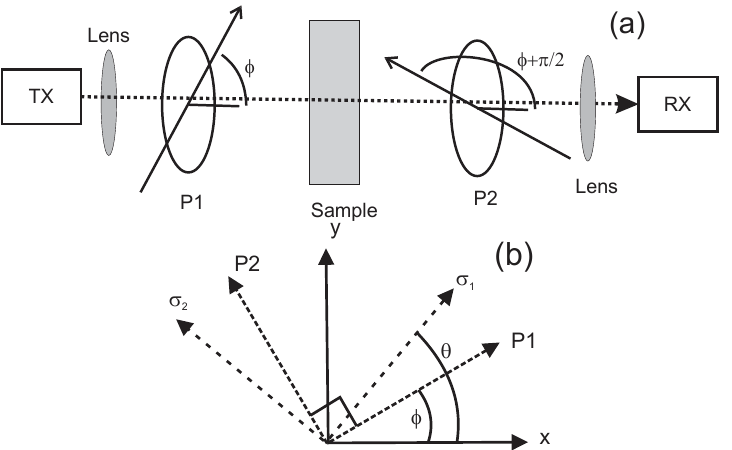
Figure 1. Experimental configuration for measurement of birefringence in a transmission mode. ( a ) relative positions of the transmitter/polarizer P1 module, birefringent sample, and receiver/polarizer P2 module. ( b ) Orientation of transmission axes of polarizers P1 and P2 relative to the laboratory x and y axes. The terahertz pulse is propagating into the page. The fast σ 1 and slow σ 2 axes of the birefringent material are assumed to be orthogonal.